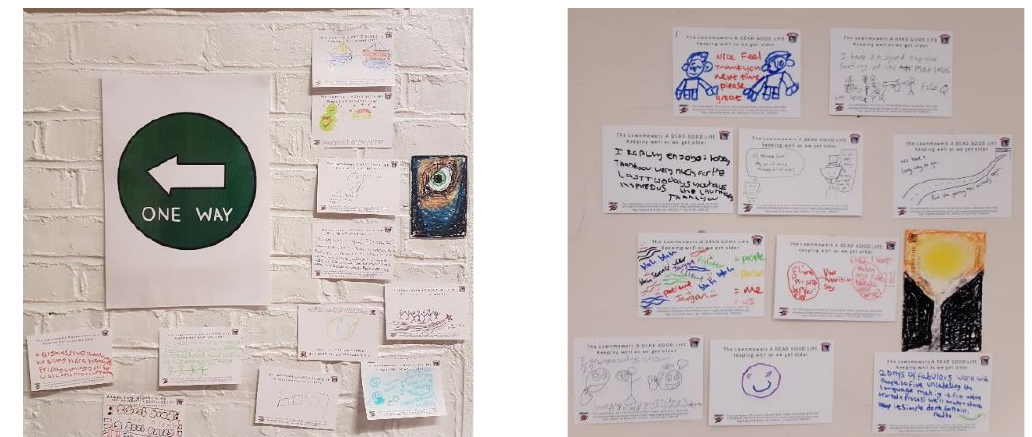
Figure 3. (left) and Figure 4. (right): Reflective postcards from day 1 and day 2 of “Un-labelling the